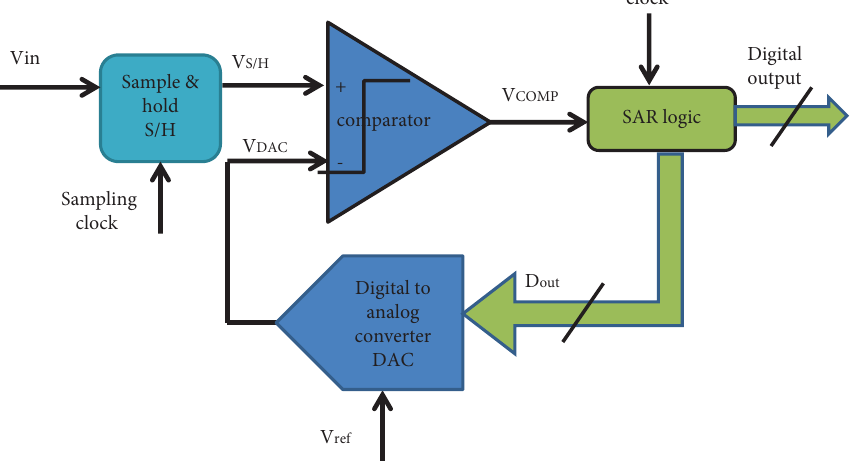
Figure 2: Block diagram of the SAR